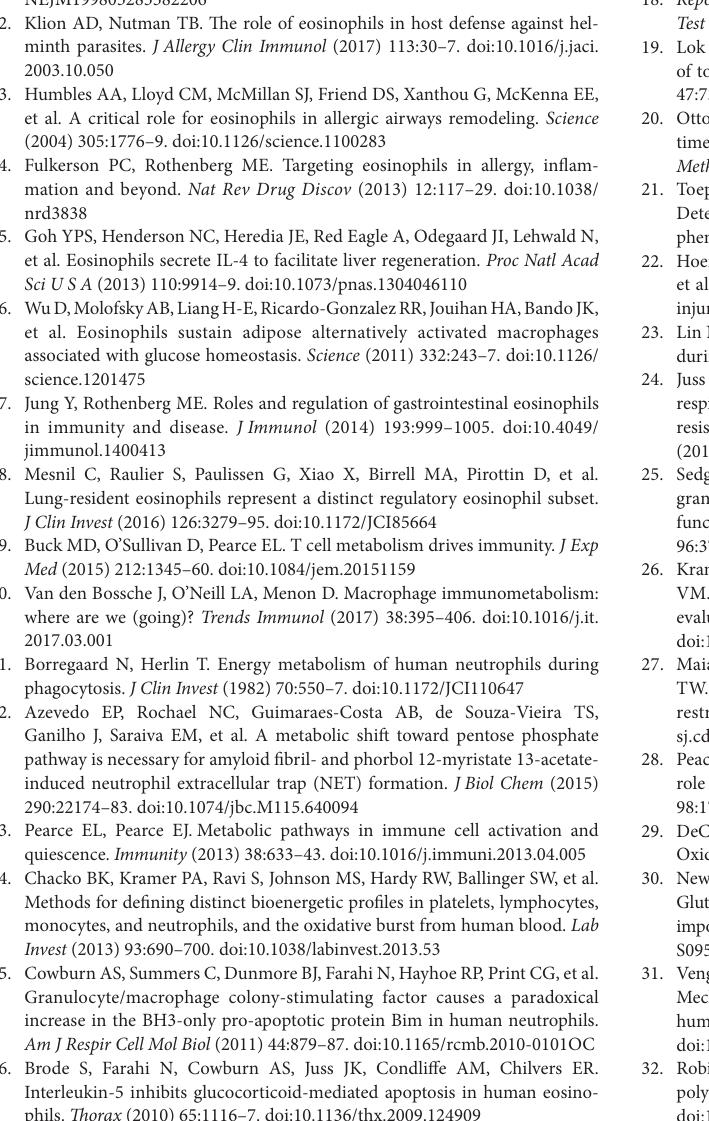
FigUre s5 | Analysis of eosinophil cross-sectional area, deformation, and area ratio using RT-DC. Analysis was performed on freshly isolated eosinophils as described in Section “Materials and Methods.” (a) Within a constriction channel, shear stress and pressure act to deform the eosinophil. (b) An image analysis algorithm determines the contour of individual eosinophils (left) and its convex hull (right), and quantifies deformation and area ratio in real-time. The cross- sectional area is defined via cell contour detection as shown and convex cell contour and convex hull area are calculated. (c) Analysis reveals cell deformation and area ratio. Eosinophils with area ratios between 1 and 1.05 are used for calculation of cellular deformation. (D) Comparison of eosinophil cross-sectional area in eosinophils from atopic and non-atopic subjects. Box-and-whiskers plot shows median ± range of six independent experiments with mean shown as + , p values calculated using a Student’s t -test. (e) Comparison of eosinophil deformation in eosinophils from atopic and non-atopic subjects. Box-and- whiskers plot shows median ± range of six independent experiments with mean shown as + , p values calculated using a Student’s t